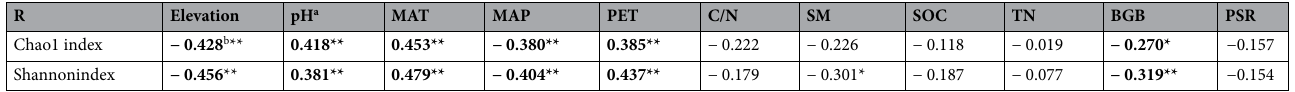
Table 2. Pearson correlations (R) evaluating the association between environmental variables and bacterial diversity (Chao1 richness, Shannon–Wiener diversity). a MAP, MAT, PET, C/N, SM, SOC, TN, BGB, and PSR respectively correspond to mean annual precipitation, mean annual temperature, evapotranspiration, carbon/ nitrogen ratio, soil moisture, total carbon, belowground biomass, and plant species richness. b Bold values indicate significant correlations ( P < 0.05).